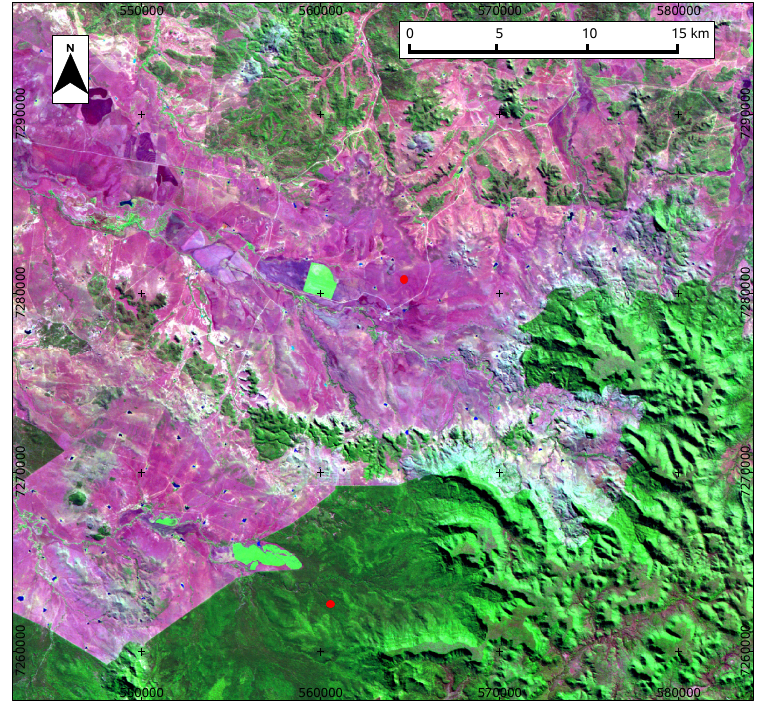
Figure 3. Detail of Landsat WRS-2 path/row 093/077, showing the two points being used for illustrative time series. Backdrop image is for 1 July 2009, and is colored with Landsat TM bands 5, 4, 2 as red, green, blue respectively. Points are marked as red dots. Northern point is in open grassland, southern point is in forest.